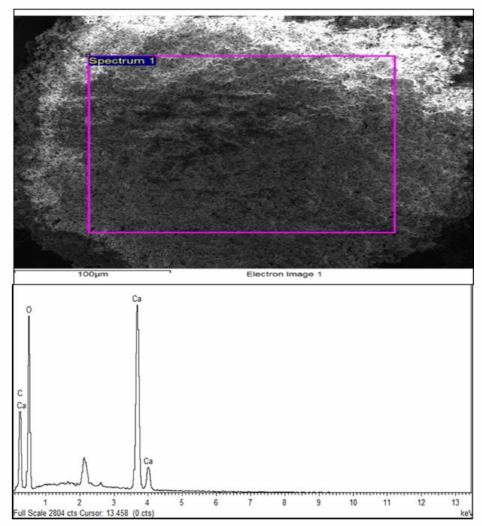
Figure 7. EDX spectrum of CaCO 3